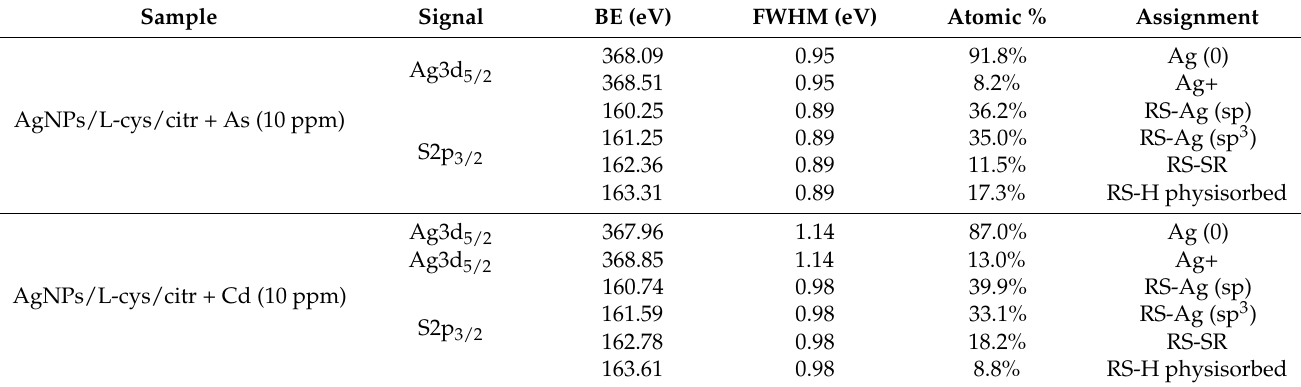
AgNPs/L-cys/citr + Cd (10 ppm)